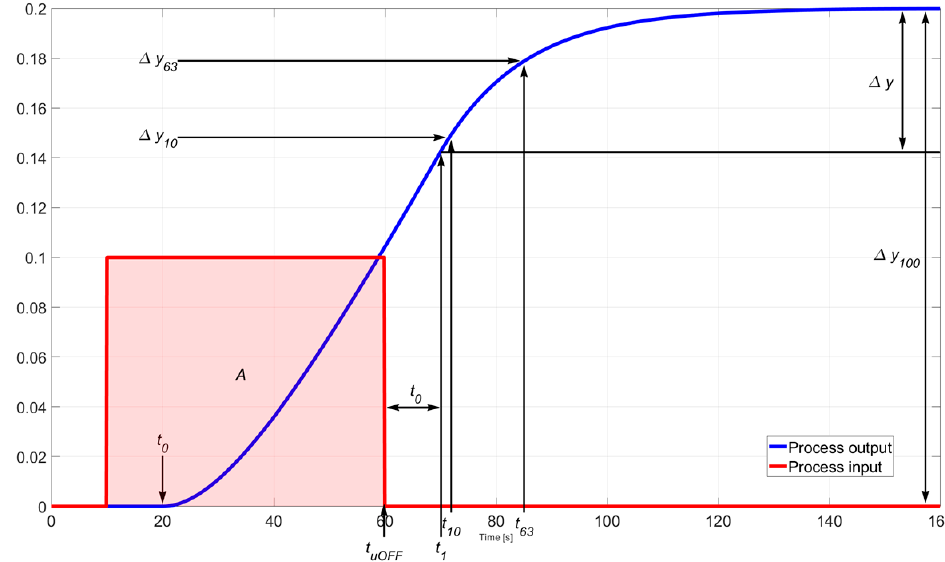
Figure 6. Process identification from wide pulse response for systems with transport delay.